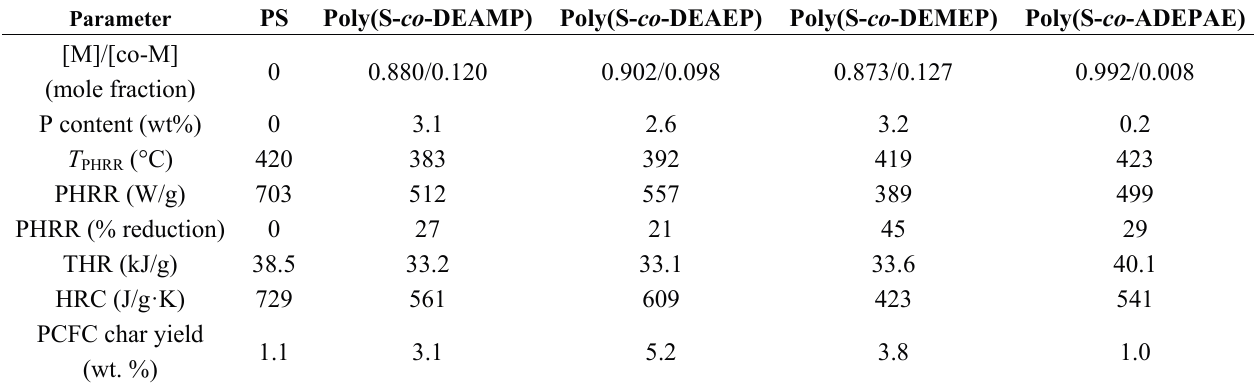
Table 7. PCFC parameters for S-based